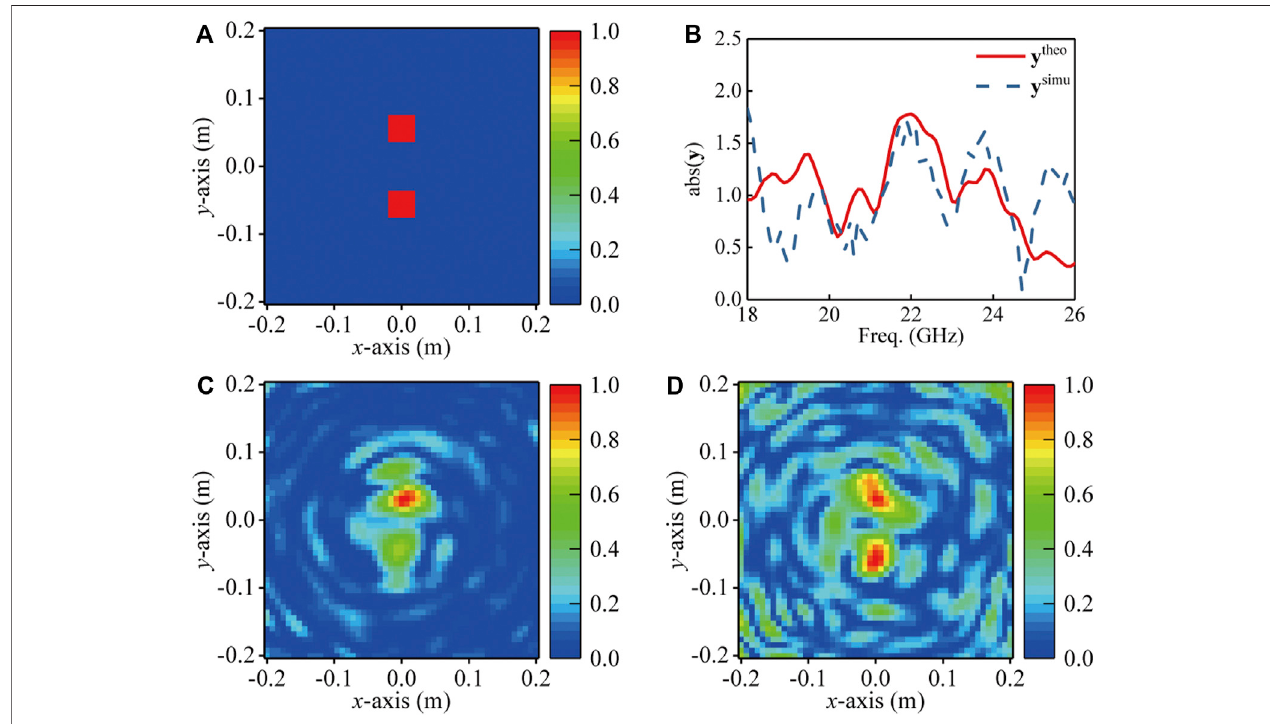
FIGURE 6 | (A) Two square PEC objects (B) Comparison of the calculated y theo and simulated y simu . (C) The reconstructed imaging x theo using y theo . (D) The reconstructed imaging x simu using y simu .